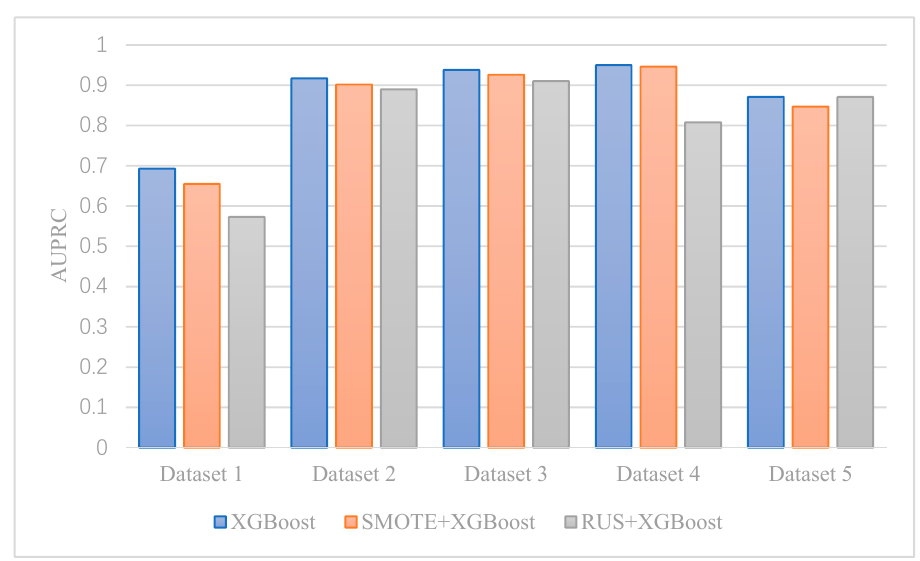
Figure 6. The impact of resampling on XGBoost.